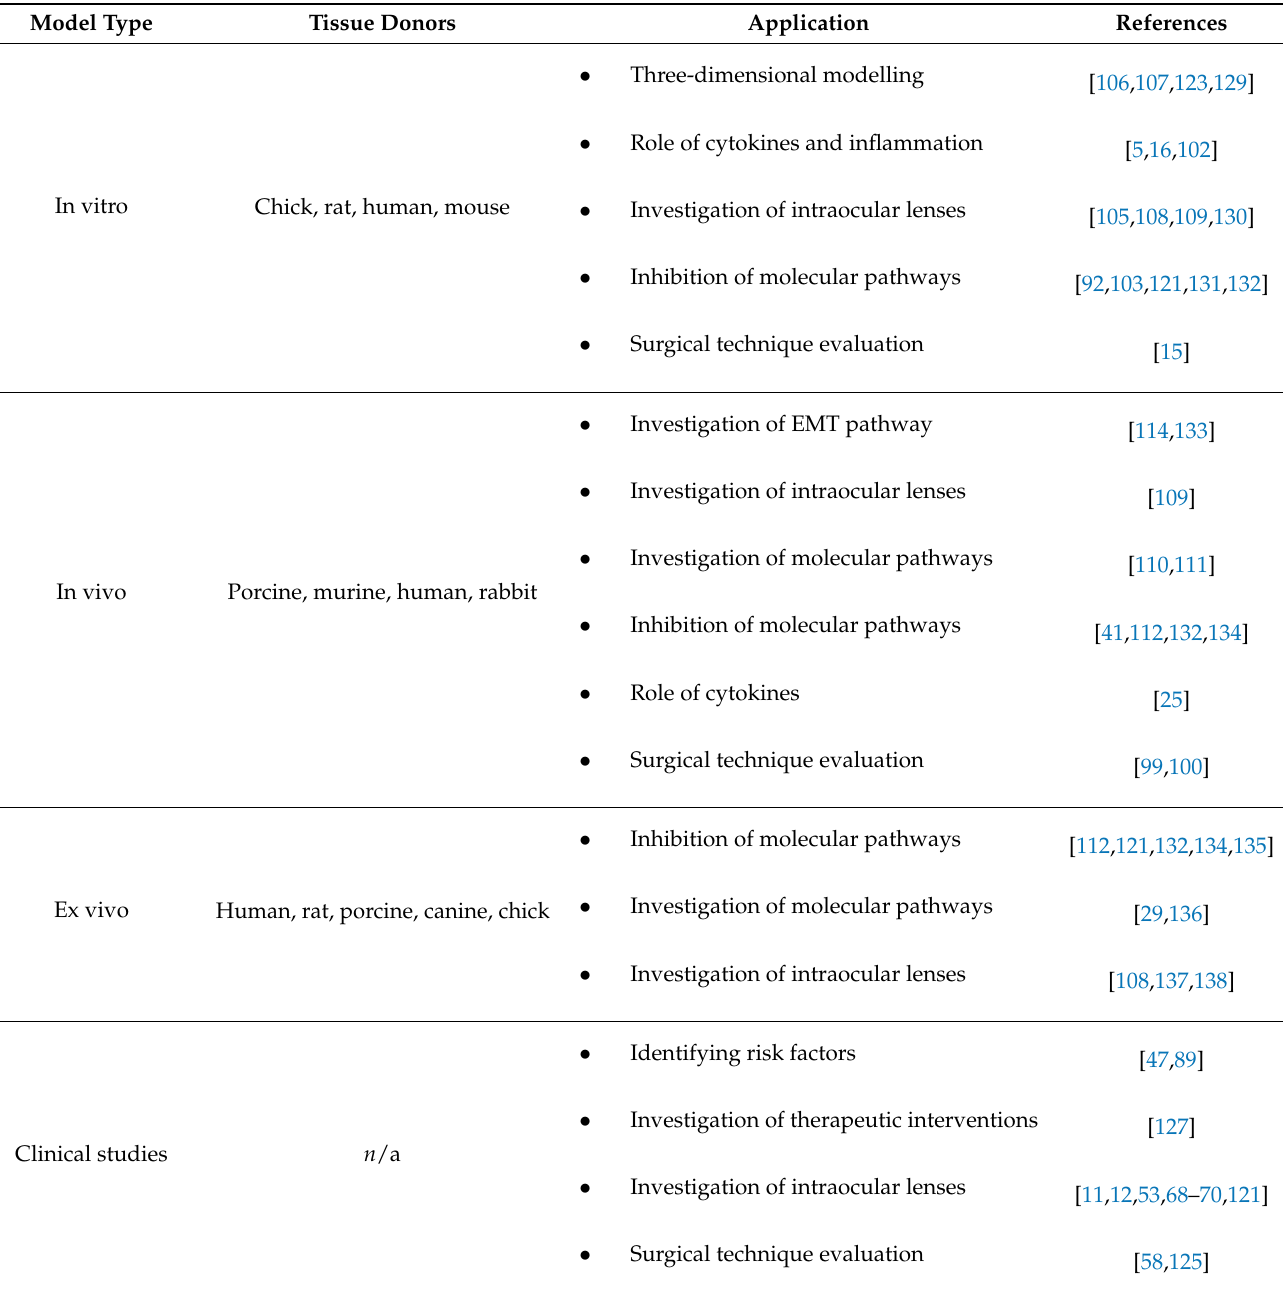
Table 1. Overview of the applications of the experimental models of posterior capsule opacification. TGF- β : transforming growth factor beta; EMT: epithelial-mesenchymal transition; LEC: lens epithelial